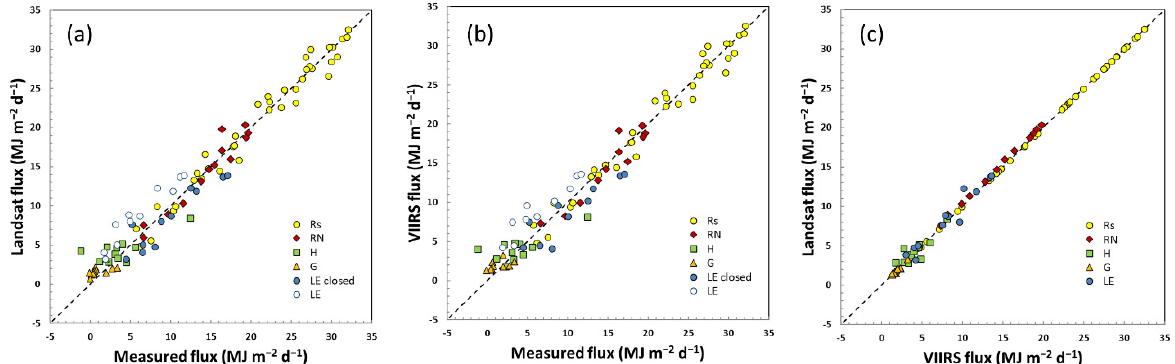
Figure 3. Scatterplots of Landsat/VIIRS-retrieved and observed daytime-integrated fluxes on Landsat overpass dates at USBi2 site. Comparisons between ( a ) Landsat and observations, ( b ) VIIRS (using Landsat SR) and observations, and ( c ) Landsat and VIIRS. Rs: solar radiation; Rn: net radiation; H: sensible heat flux; G: soil heat flux; LE: latent heat flux, where ‘closed’ indicates energy balance closure. Rs is derived from CFSR data, so it is the same for Landsat and VIIRS.